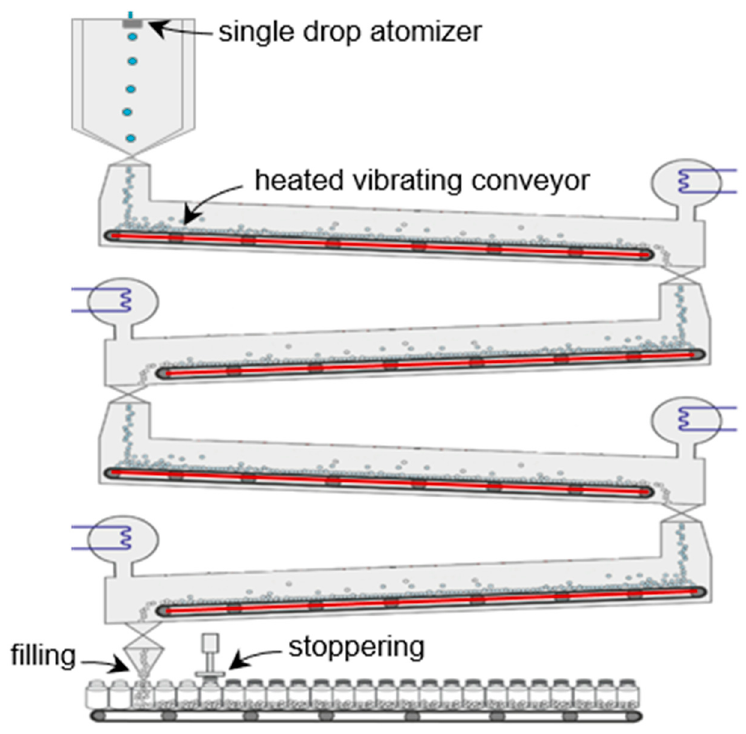
Figure 7. Schematic design of the LYnfinity.